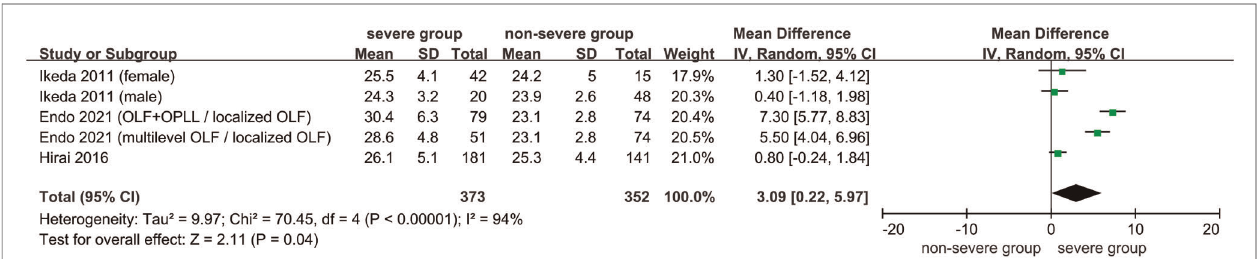
FIGURE 7 | Meta-analysis for the relationship of BMI with the severity of